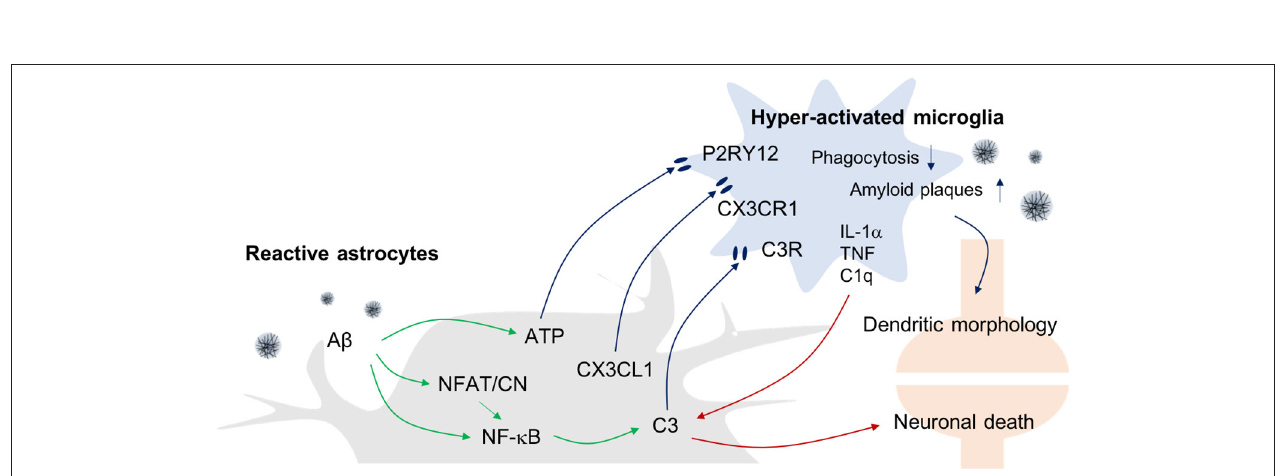
FIGURE 2 | Astrogliosis-Microgliosis Axis (AMA) in AD. Schematic showing the crosstalk between reactive astrocytes and hyper-activated microglia in AD. It has been reported that reactive astrocytes release ATP, CX3CL1, and C3 to activate microglia, whereas the activated microglia release inflammatory molecules such as IL-1 α , TNF- α , and C1q to increase C3 expression in astrocytes, which consequently causes an increase in AD pathology indices such as A β plaques and neuronal death.